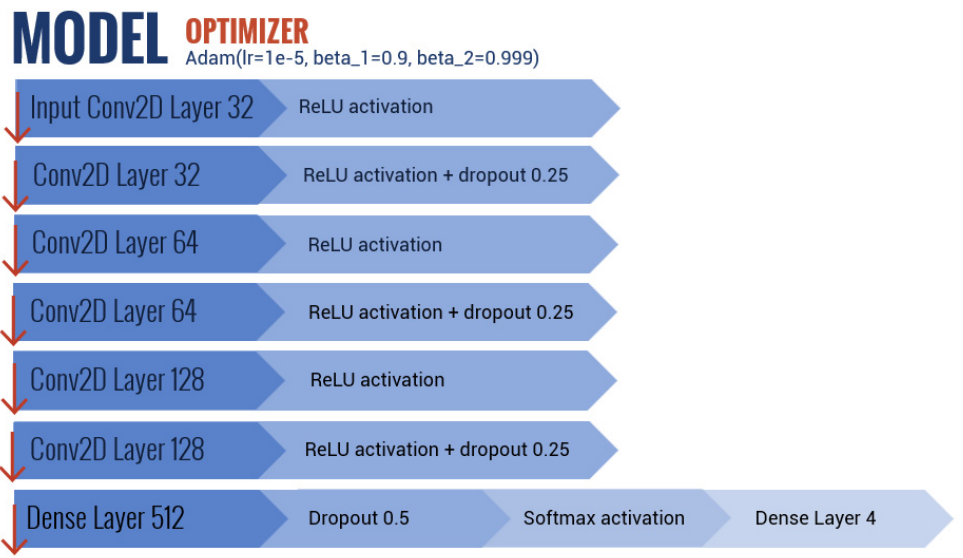
Figure 7. Structure of the proposed CNN.